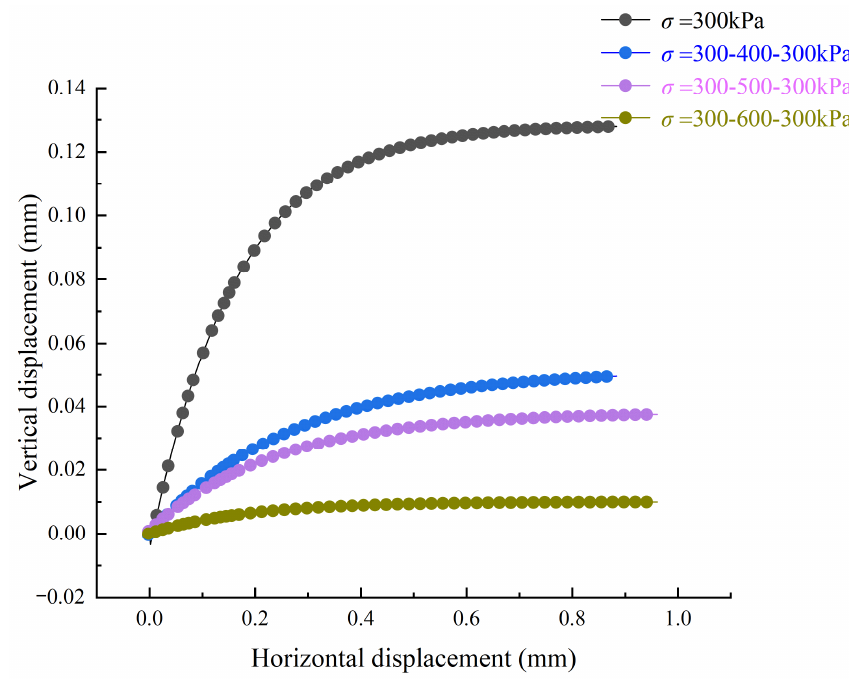
Figure 11. Vertical displacement and horizontal displacement curve of the contact surface.